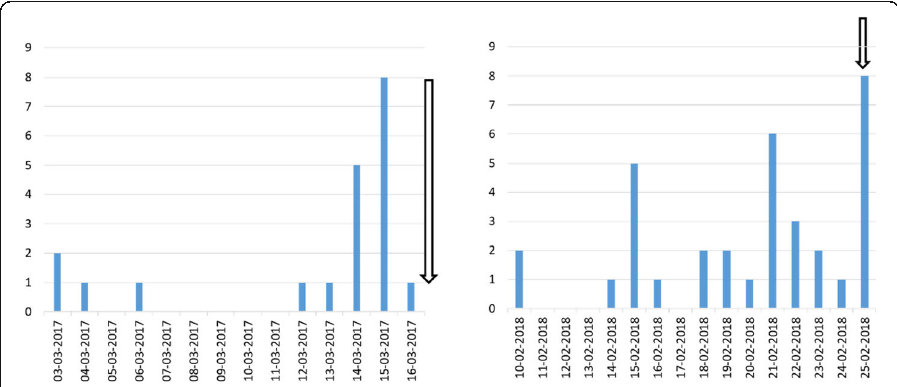
Fig. 11 Temporal distribution of posted messages in Topic 7. In the left side, the academic year of 2016/ 2017 and in the right side, the academic year of 2017/2018. The arrows show the deadlines for delivery of work and / or